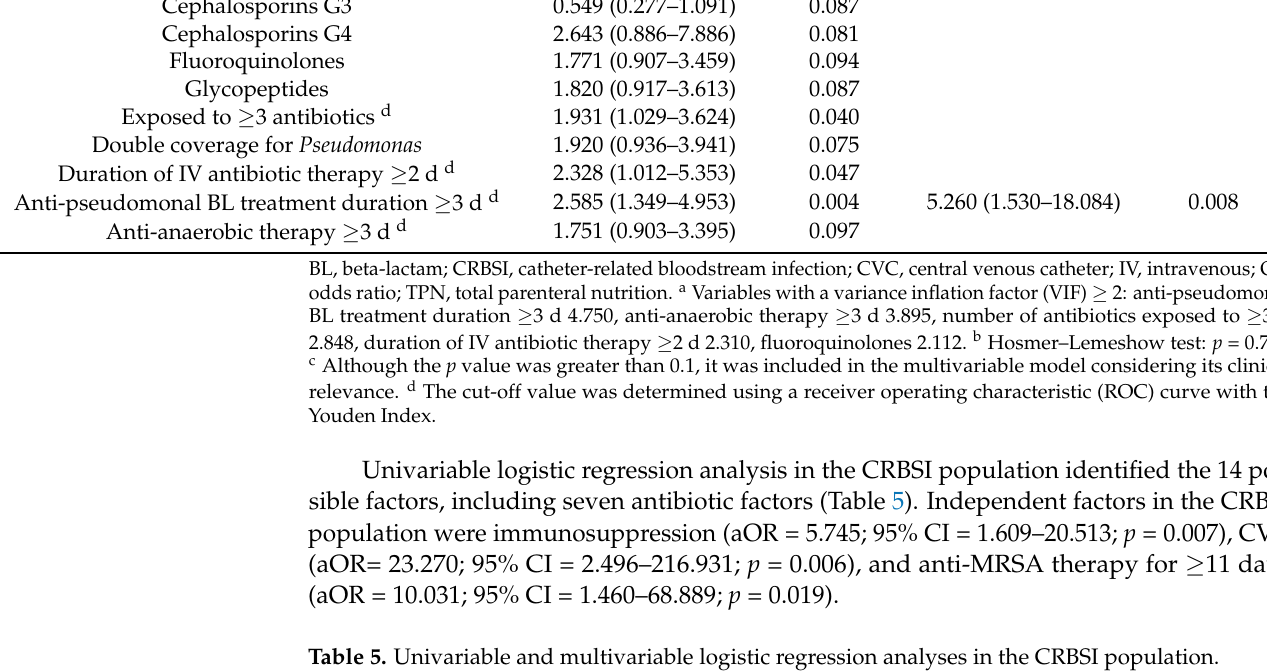
Table 5. Univariable and multivariable logistic regression analyses in the CRBSI